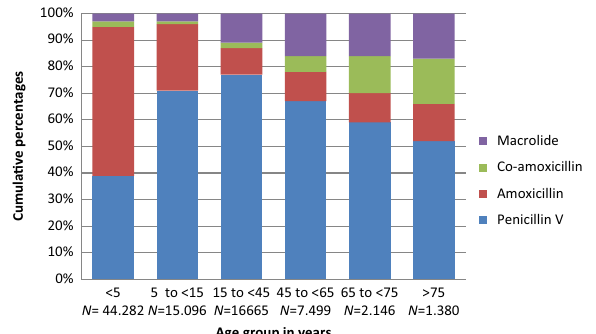
Fig. 2 Acute otitis media. Prescribing pattern by age group ( N = 87.064)